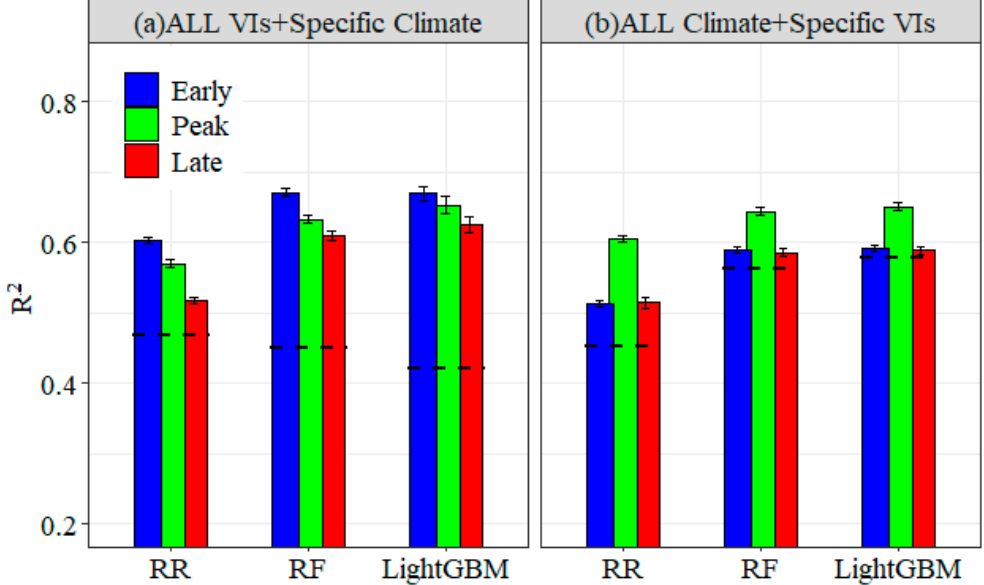
Figure 5. ( a ) The model performance (predicted R 2 ) using VIs during the whole growing season and climate data during a specific stage, either for Early (Oct. and Feb.), or Peak (Mar. and Apr.), or Late stage (Jun. and Jul.). The dashed line in ( a ) represents the benchmark model performance by only using VIs. ( b ) The model performance (predicted R 2 ) using the climate data during the whole growing season and VIs during a specific stage (the same stage in (a)). The dashed line in ( b ) represents the benchmark model performance by only using climate data. The error bars are one standard deviation of predicted R 2 from 100 ensembles by randomly dividing training and testing datasets.